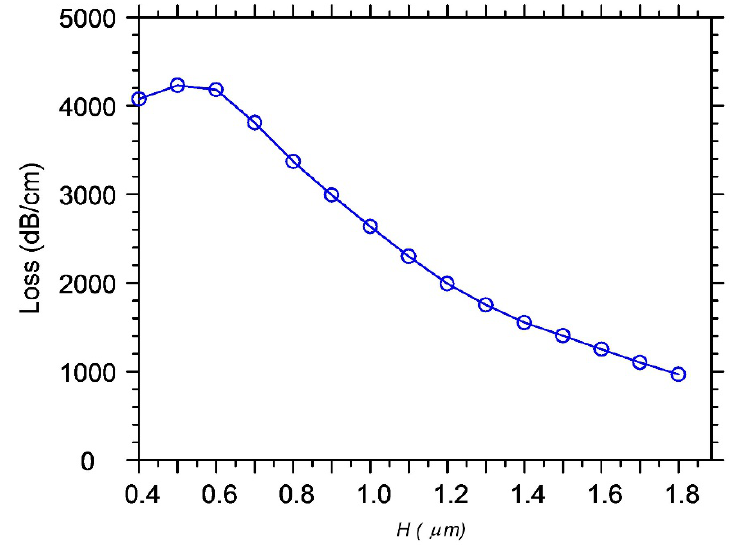
Figure 15. Dependence of the propagation loss in the segmented grating placed near the silicon semi space as a function of the different grating height H . It is obtained as the transmitting power of the Gaussian optical beam launched into polymer strip connected with segmented grating. M = 128, W = 1.0 µm, h = 0.25 µm, w = 0.45 µm, d = 0.1 µm. Simulation made by 2D FDTD.